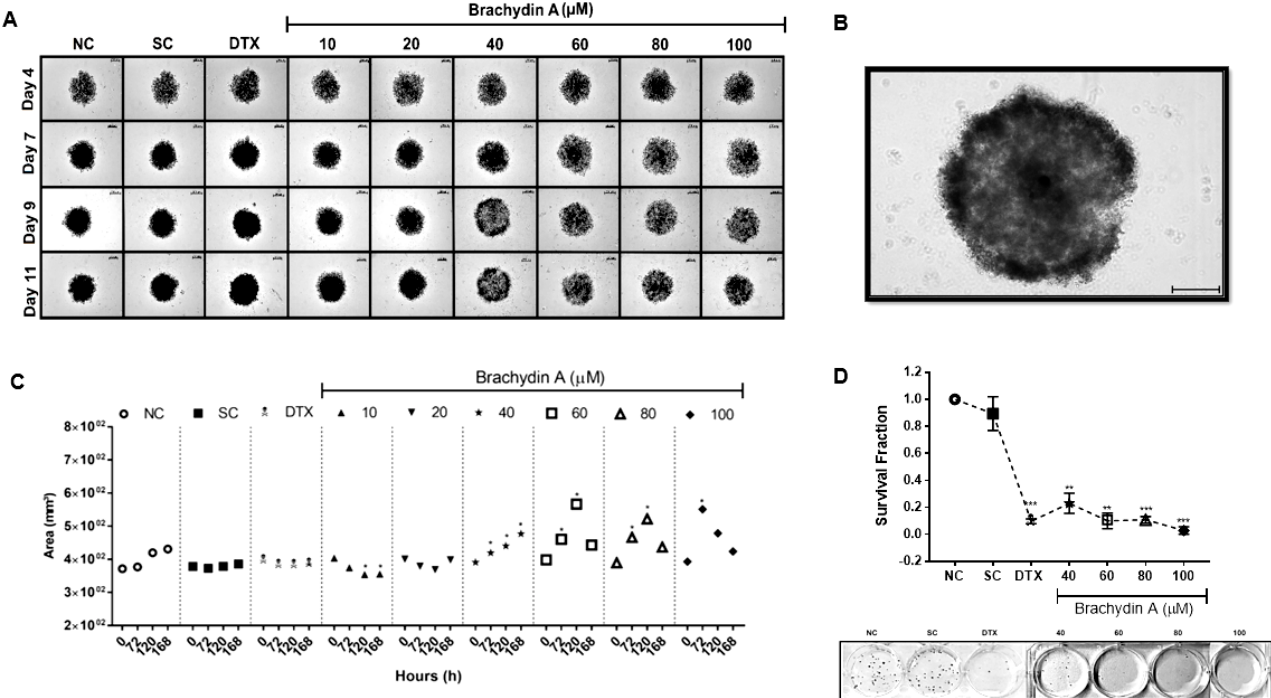
Figure 2. ( A , B ) Morphology and integrity of DU145 spheroids after treatment with Brachydin A (BrA) for 0 (Day 4), 72 (Day 7), 120 (Day 9), and 168 h (Day 11). All images were obtained using the Axio Cam MRc capture system coupled to Axio LabA1 microscope, using the 10× (A) and 40× ( C ) objectives. ( C ) Volume (area/ μ m³) of DU145 spheroids after 0 (Day 4), 72 (Day 7), 120 (Day 9), and 168 h (Day 11) of exposure with BrA and respective controls. ( D ) Survival fraction of DU145 cells disaggregated from spheroids treated for 72 h with BrA and their respective controls. All data points from volume/morphology represent the mean of six ( n = 6) spheroids/replicates analyzed in three biological experiments ( n = 3). * Values statistically different from the NC group at the point (date) (* p < 0.05; ** p < 0.01; *** p < 0.001; ANOVA followed by Dunnett’s post-test). NC: negative control (RPMI 1640); SC: solvent control (1% DMSO); DTX: Docetaxel (50 μ M; positive control). Scale: 200 μ m.